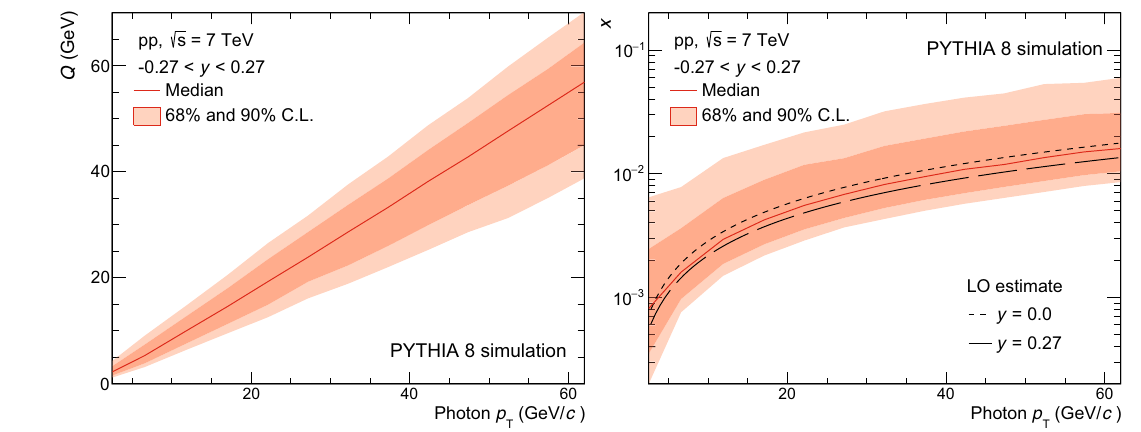
Fig. 1 The scale Q (left), and the fraction x (right) of longitudinal momentum of the initial state partons of the hard process for pho- ton production at midrapidity versus photon p T for pp collisions at √ s = 7 TeV, from a PYTHIA 8 [19] simulation. The x values of both